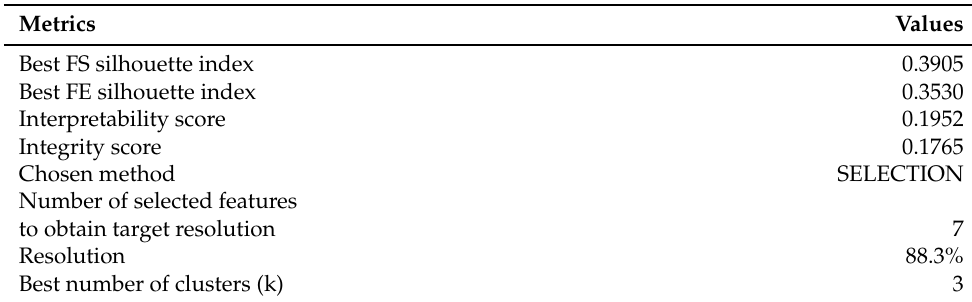
Table 7. Algorithm results using interpretability-oriented = 0.5, integrity-oriented = 0.5 and target- resolution =